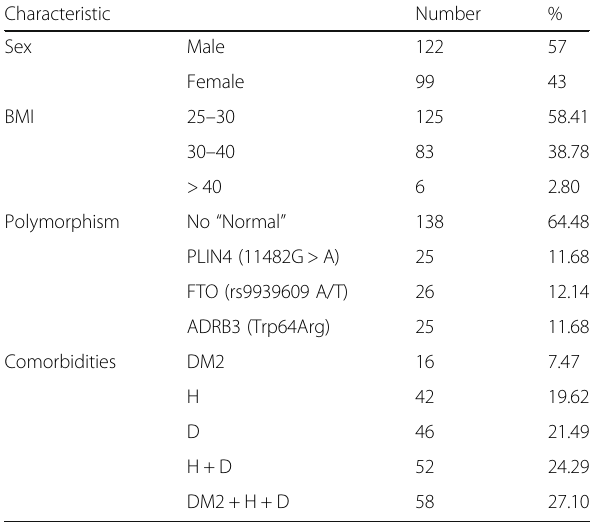
Table 1 Subjects description by sex, age, BMI and polymorphism Characteristic